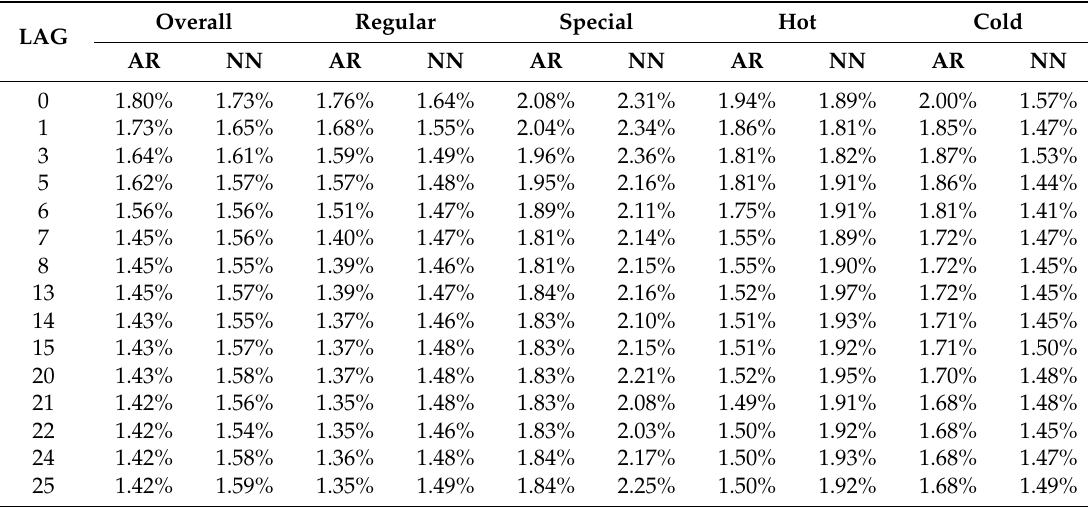
Table 8. Forecasting error (RMSE) with different lagged feedback.